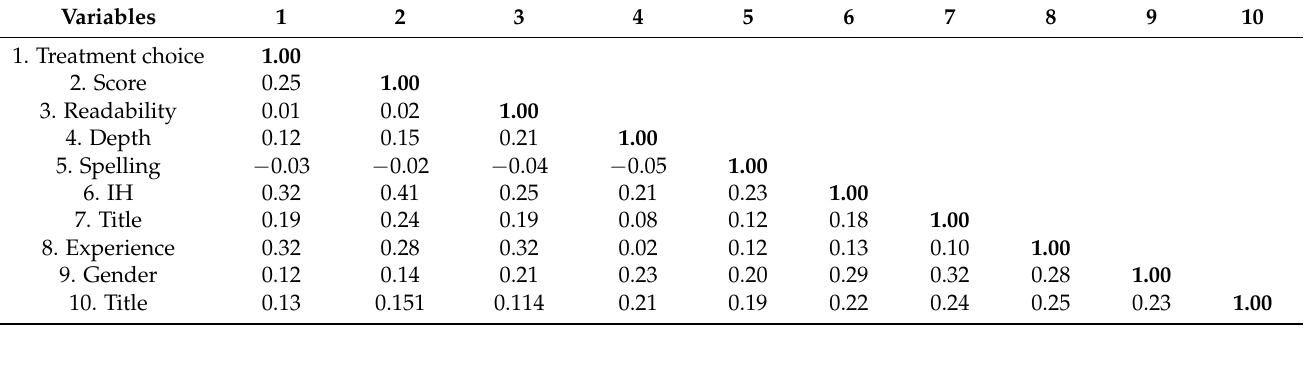
Table 2. Variables correlations.